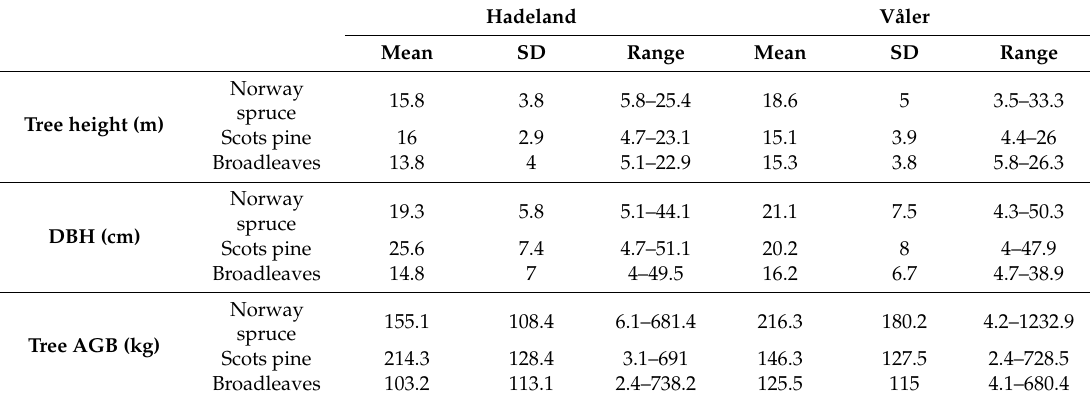
Table 1. Statistics of the field data divided by species for the two